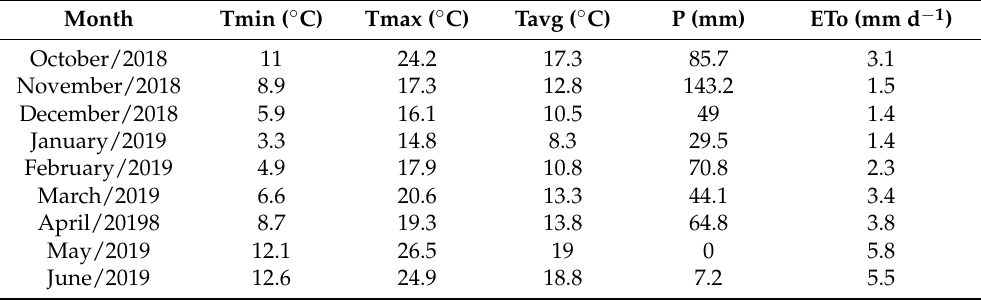
Figure 2. Monthly average air temperature and precipitation for the 1971–2000 period at the Santar é m weather station. Table 1. Monthly averages of minimum, maximum, and average temperatures, precipitation, and reference evapotranspiration (ETo), recorded during the experimental period at the Barragem de Magos weather